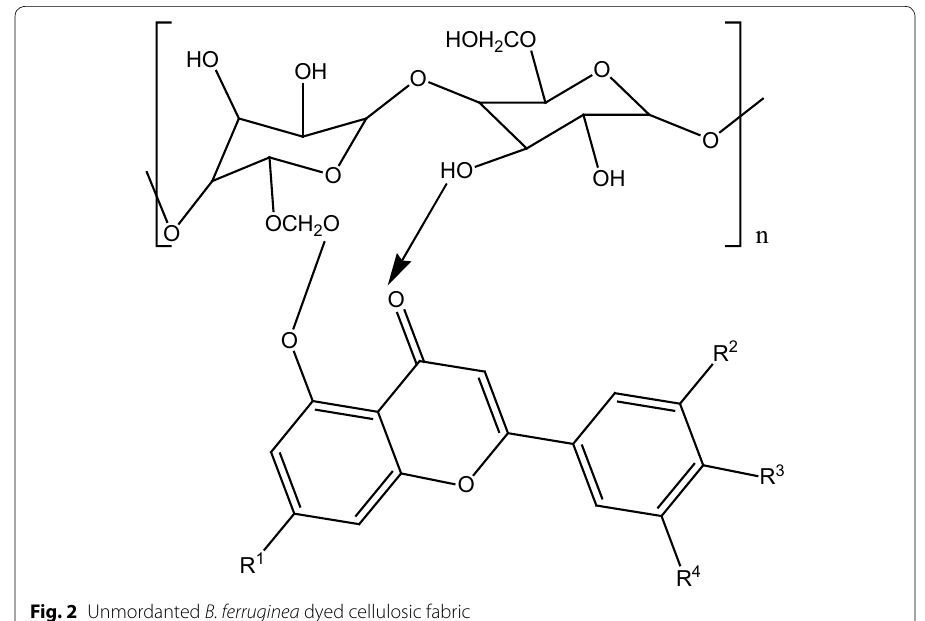
Fig. 2 Unmordanted B. ferruginea dyed cellulosic fabric